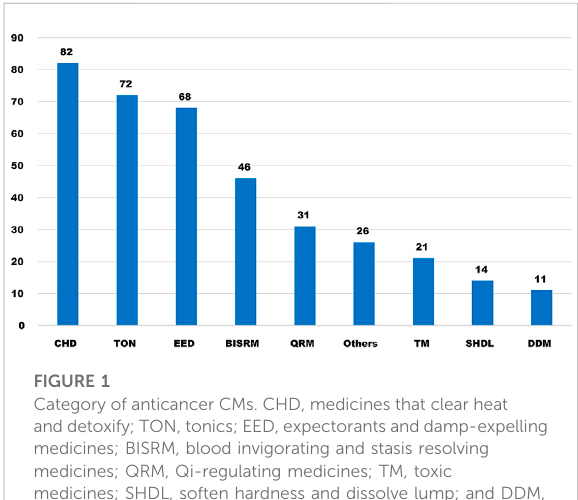
damping – draining